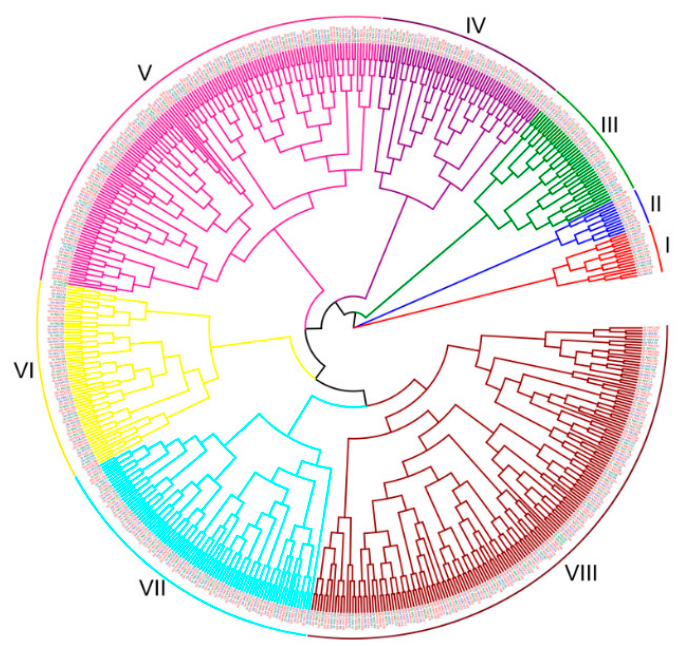
Figure 1. Phylogenetic analysis of NAC proteins from three cotton genomes. The labels in color indicate NAC proteins form G. hirsutum (red), G. arboreum (blue) and G. raimondii (green), respectively. 2.2. Gene Chromosomal Location, Duplication and Synteny Analysis of NACs in Cotton Total 298 out of 299 Gh_NACs were distributed on all chromosomes with number range from 7 to 17 and the other one located on scaffold (Figure S1A,B). Ga_NACs